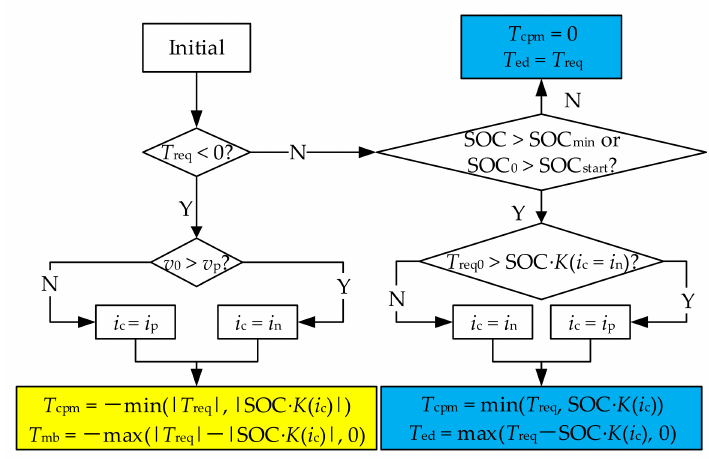
Figure 13. Control